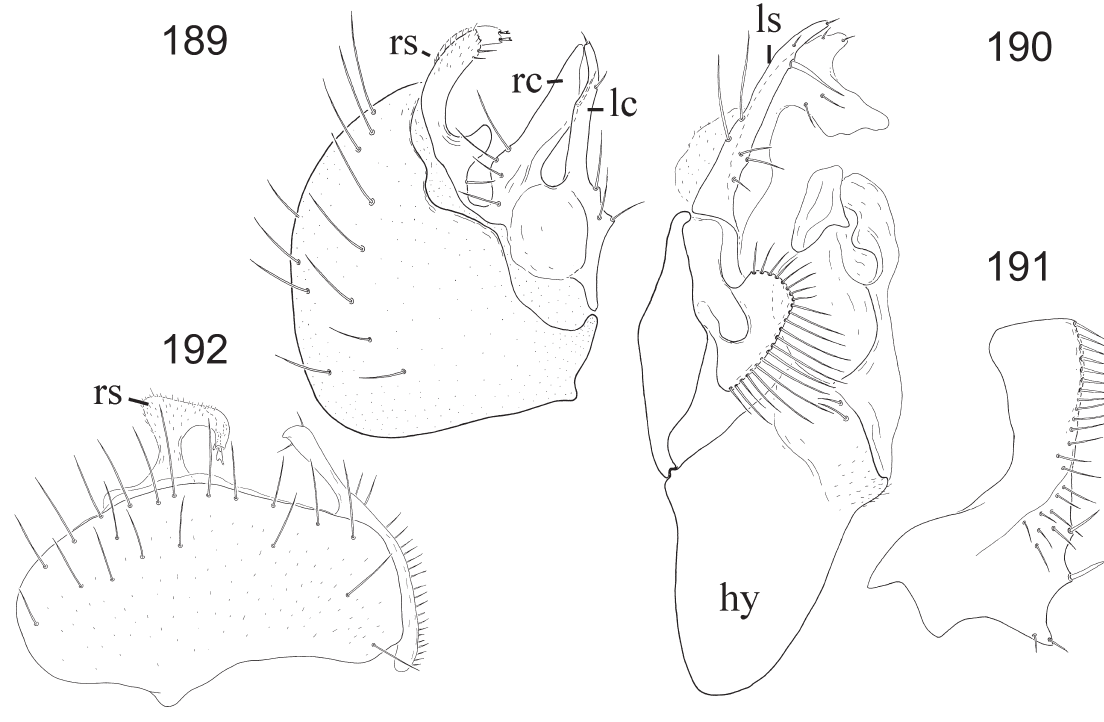
Figs 189-192. Nanodromia phukhao Grootaert & Shamshev, 2003, ♂ terminalia. 189 . right epandrial lamella with cerci, dorsal view. 190 . left epandrial lamella with hypandrium, lateral view. 191 . left surstylus, dorsal view. 192 . right epandrial lamella, lateral view. (after Grootaert & Shamshev